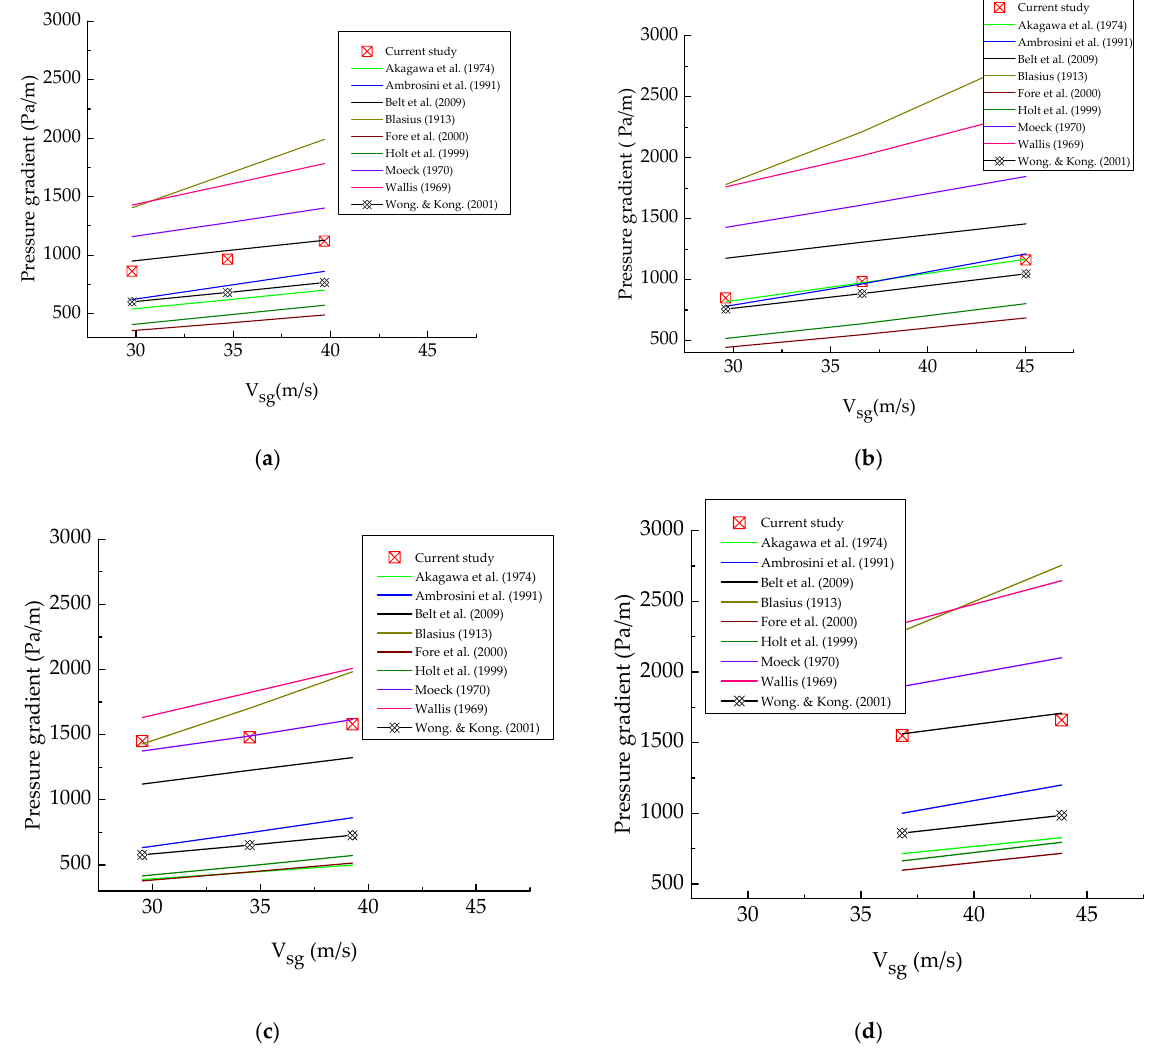
Figure 9. Pressure gradient predictions using selected fi correlations at 100 ( a , b ) and 200 ( c , d ) mPa s.